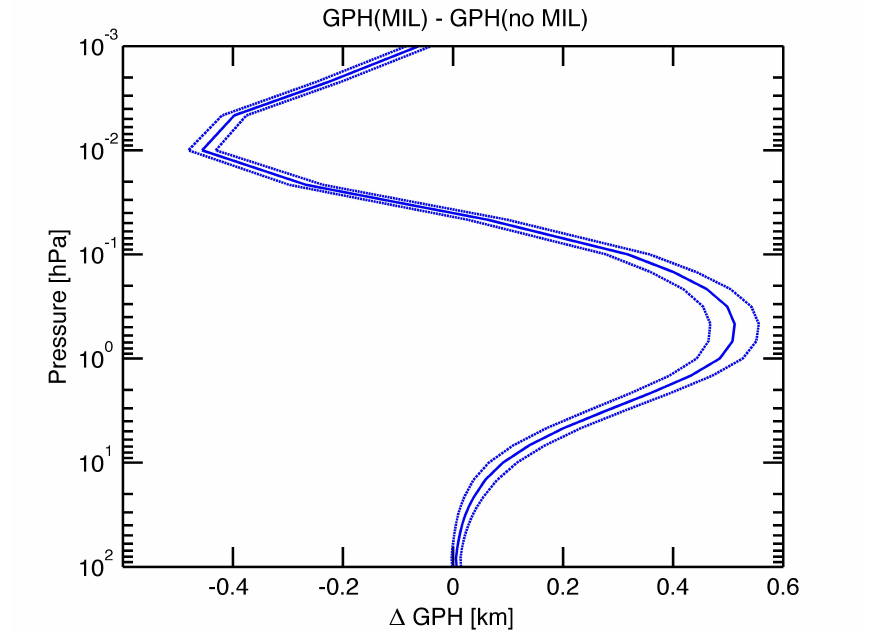
Figure 4. Geopotential height (GPH) difference profile for “MIL” minus “no MIL”. A relative increase of GPH (or pressure) is present in the lower mesosphere at 0.5 hPa when an MIL occurs. Dashed lines show the error of the